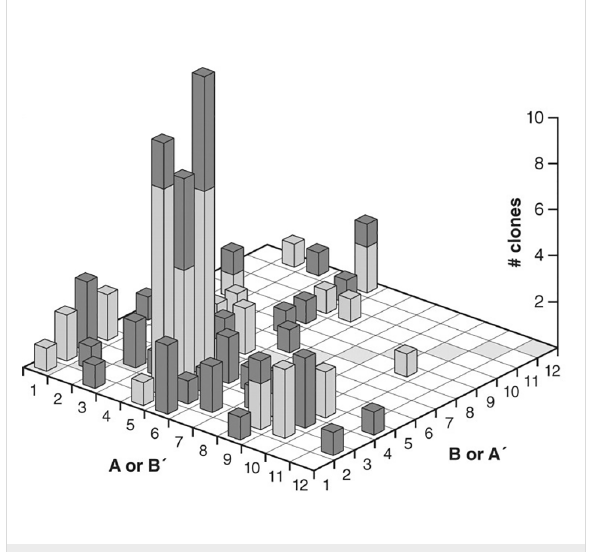
Figure 9: Distribution of the species present in the reaction mixture after 20 serial transfers. E and E’ molecules are represented by the dark and light shaded bars, respectively. Note how certain species have come to dominate the population, particularly A 5 B 3. Moreover, only 7 molecules were found to be paired to their original partner (cor- responding to the shaded diagonal)